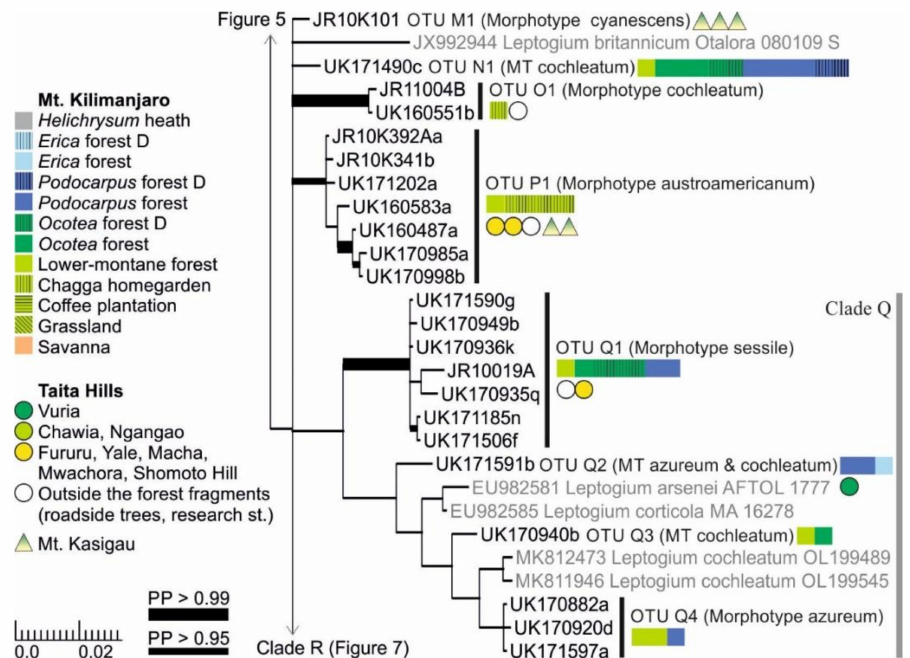
Figure 6. Clades M–Q of the Bayesian tree of the genus Leptogium based on the mtSSU and 5.8S marker regions (Figure S2). Newly obtained sequences are in black, including one specimen representing each mtSSU variant; all specimens belonging to each clade are listed in Table S1. For more detailed explanation, for example, for the colors and shapes indicating the distribution and abundance of taxa, see the caption of Figure 2. MT = Morphotype(s); D = disturbed; PP = posterior probability (for the precise values, see Figure